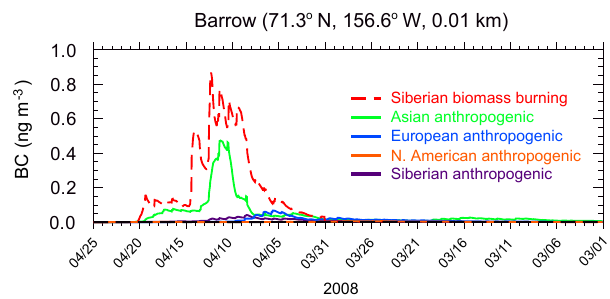
Figure 7. Same as Fig. 6b but for BC at 750hPa above